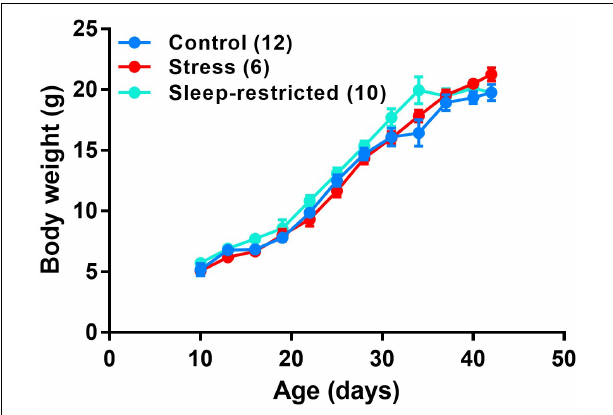
FIGURE 1 | Growth curves of male C57BL/6J mice under three conditions: control, stress, and sleep-restriction. Each point represents the mean ± SEM for the number of mice indicated in